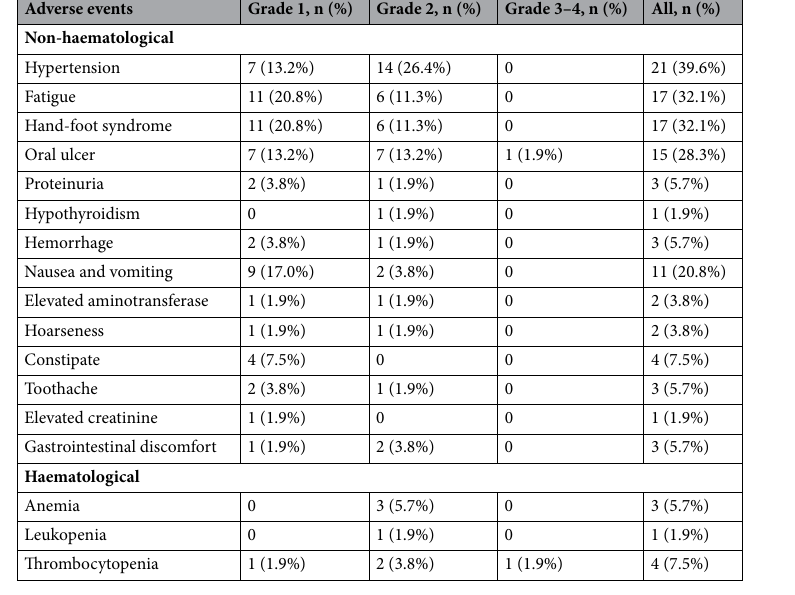
Table 5. Major treatment-related adverse events, n